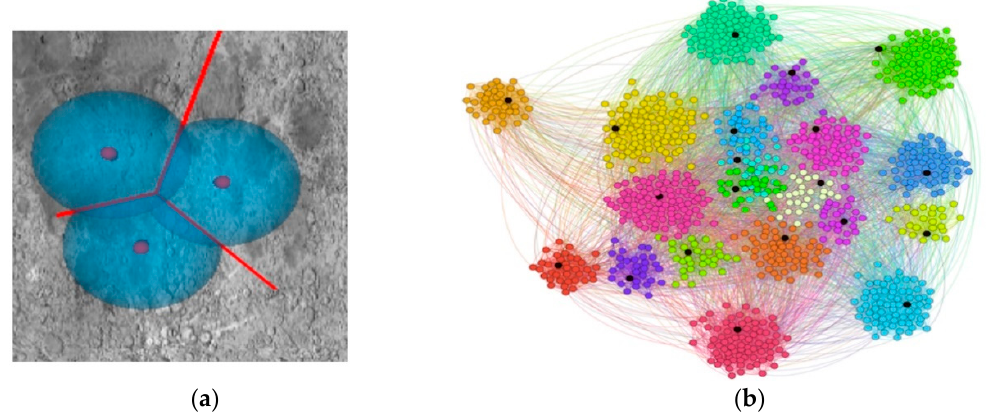
Figure 18. Voronoi diagrams. ( a ) Illustration of Voronoi partitioning in 2D Euclidean space for 3 BT cells. ( b ) Voronoi diagrams for graphs represented by the k-mean application developed by us. The generating nodes are displayed in black.